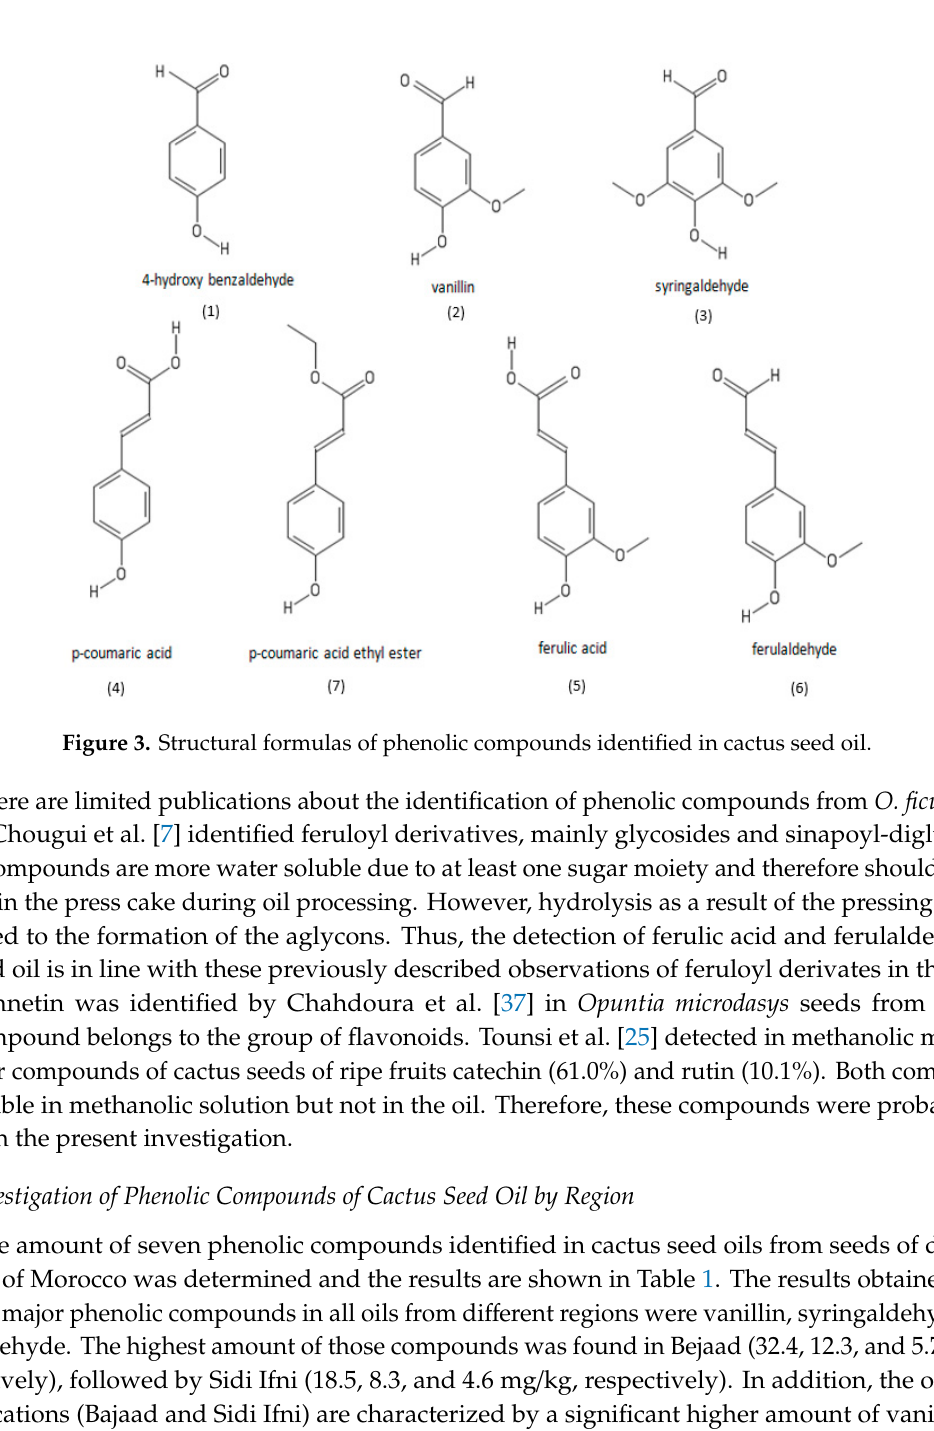
Table 1. Phenolic compounds composition of cactus seed oil from different region of Morocco expressed in mg/kg and shown as mean ± SD ( n = 3). Statistical difference was determined by one- way ANOVA followed by Tukey post-hoc test. Different letters in the same line comparing the regions represent statistically significant results at 95% confidence interval.